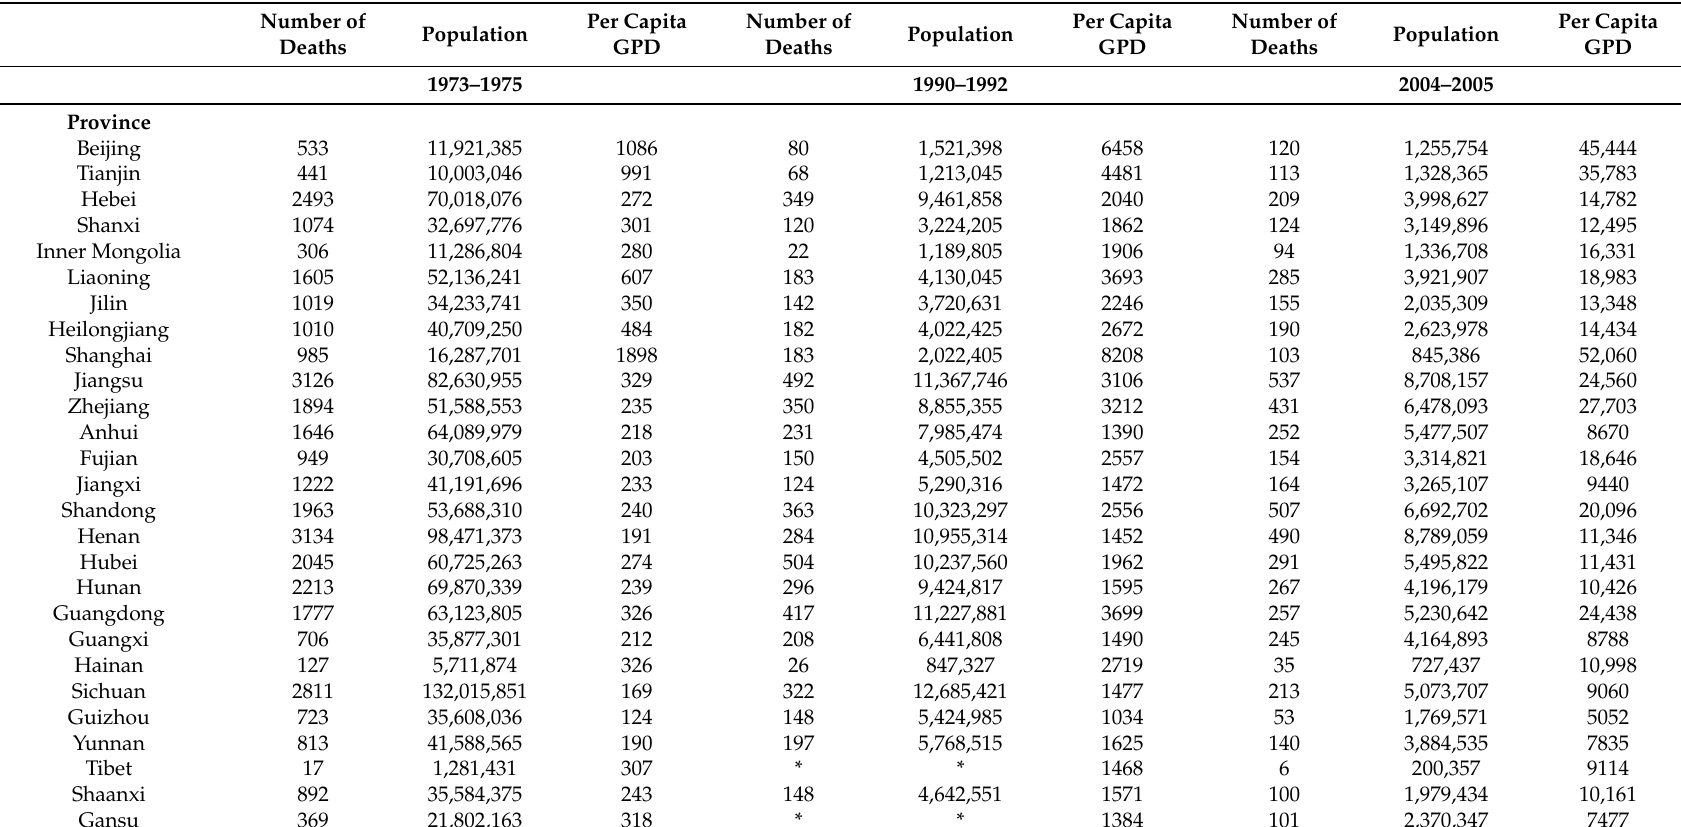
Table B1. Characteristics of the study